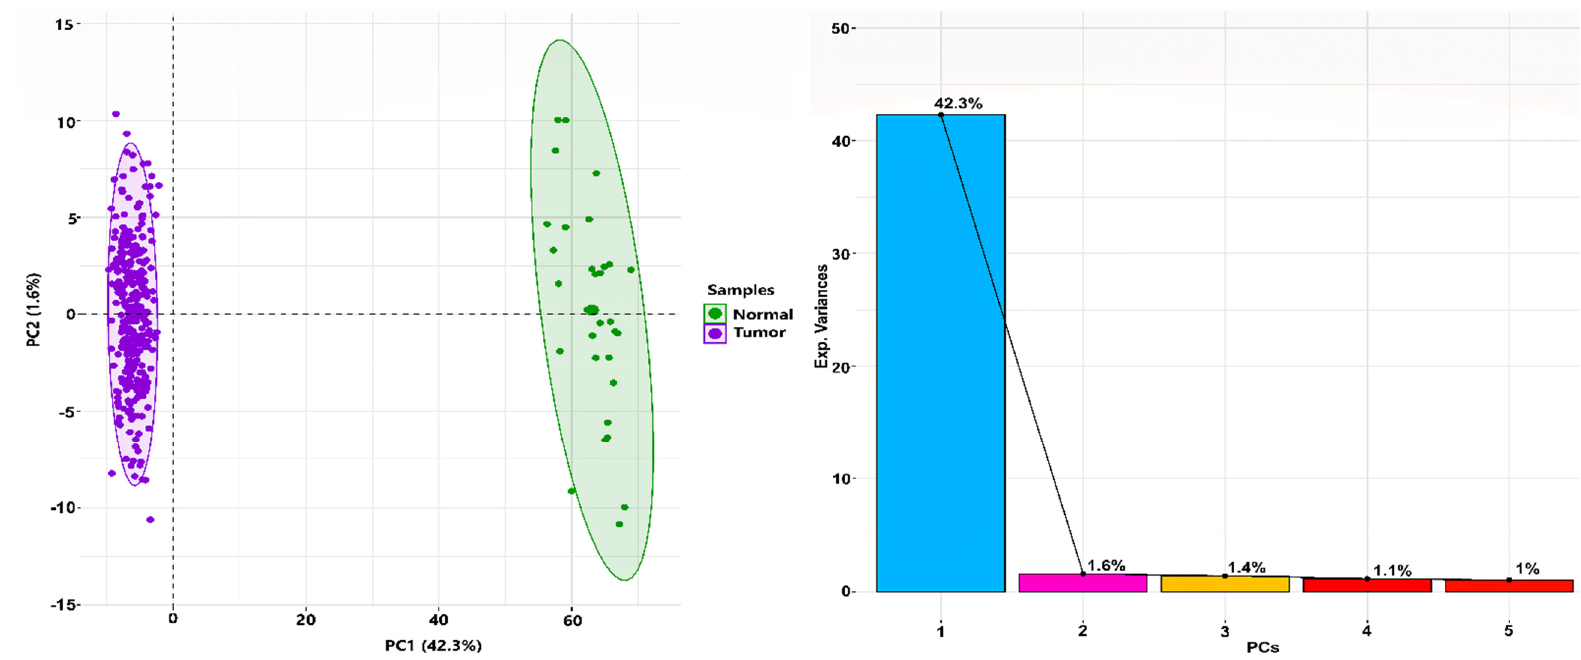
Figure 1. PCA plot in the left panel representing the variation in the expression data between normal and tumor samples. Each point in the plot shows the overall expression value of 916 DEGs. The color of each point represents the disease status: green for normal and magenta for tumor. The percentages of total variation across the first two principal components (PCs) are shown on the x and y axes, respectively. It can be observed that both the normal and tumor samples are clustered independently and distinctly. Scree plot in the right panel showing percentage of explained variances (on y -axis) captured by their corresponding PCs (on x -axis).